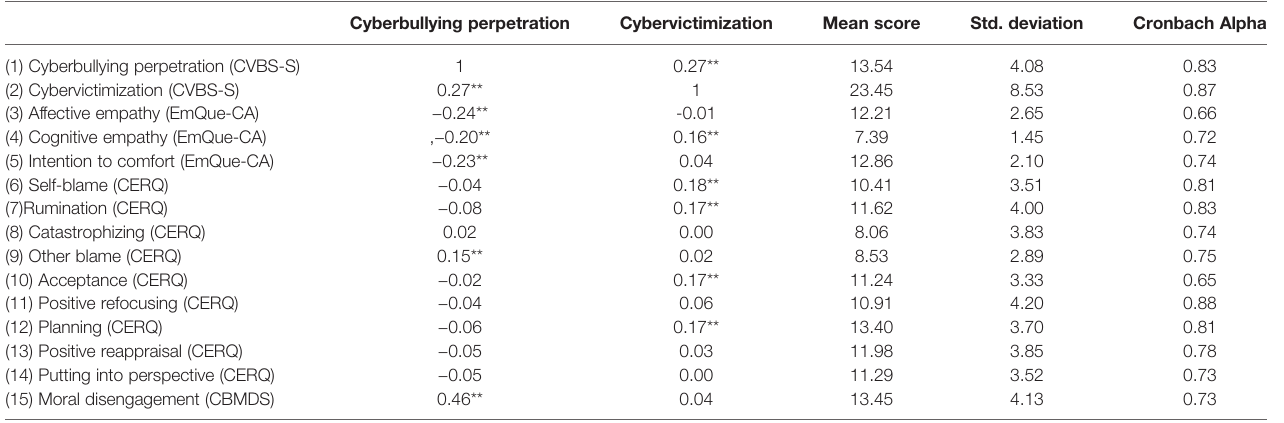
TABLE 1 | Descriptive statistics and Spearman correlation for the